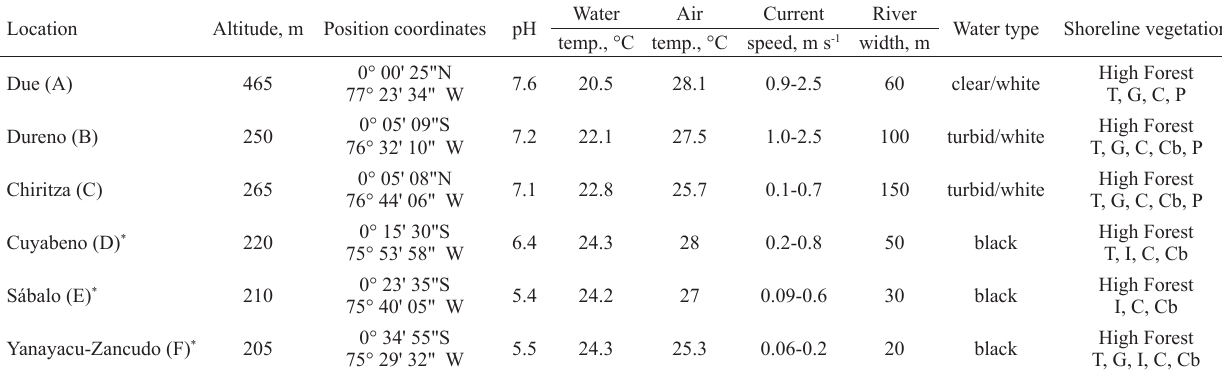
Tab. 1. Environmental condition at collecting sites in the Aguarico River basin of Eastern Ecuador, 1999 (see Fig. 1 for locations). Codes for dominant shoreline vegetation at each site are: T = Tessaria sp . , G = Gynerium sp . , C = Cecropia sp . , Cb = Ceiba sp . , P = Palmae, I = Inga sp . Positions were determined with a hand-held GPS, pH (average of monthly records) was measured with hand-held pH meter (± 0.2), and temperatures are monthly averages made with mercury thermometer. Locations marked with asterisk were in mouths of